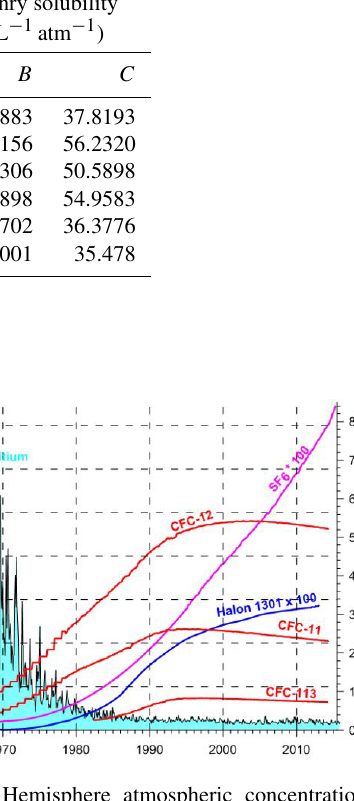
Figure 2. Southern Hemisphere atmospheric concentrations of CFC-12, CFC-11, CFC-113, SF 6 , Halon-1301 and tritium, using data from NOAA (available at ftp://ftp.cmdl.noaa.gov/hats) for the CFCs and SF 6 and from Morgenstern and Taylor (2009) for tritium. Concentrations of Halon-1301 in the Northern Hemisphere are very similar to those in the Southern Hemisphere (see Fig. 1 in Beyer et al., 2014 and references therein), suggesting Halon-1301 is well mixed in the atmosphere and can be applied as an age tracer in both